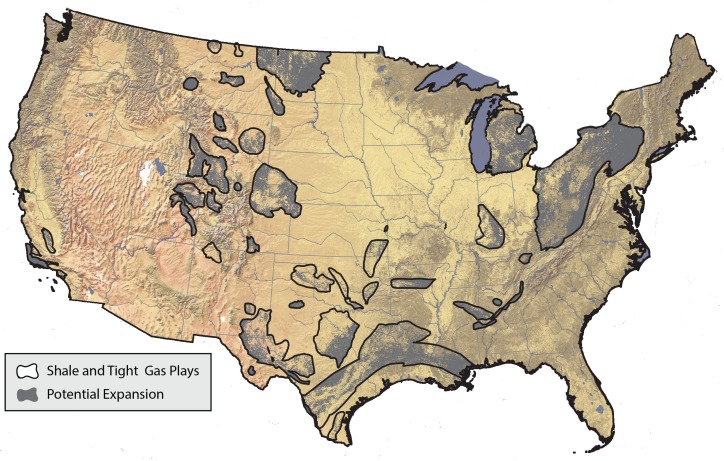
Areas at risk of development from unconventional oil and gas drilling that had previously not experienced conventional oil and gas drilling.We included EIA’s shale and tight oil and gas plays, but removed areas of existing conventional oil and gas development, based on historical oil and gas exploration and production wells drilled between 1900 and 2006 in the United States [73]. We identified and removed the 666,009 km2 that have or had well activities in the past.